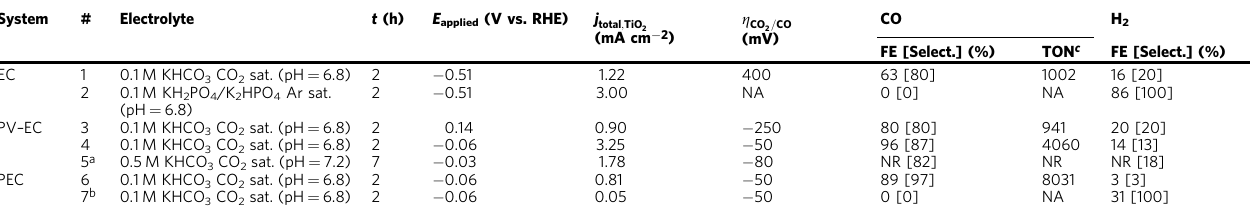
a Under continuous gas fl ow. b No catalyst.